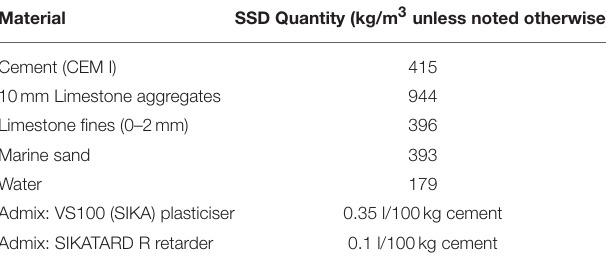
TABLE 1 | Control mix design. Material